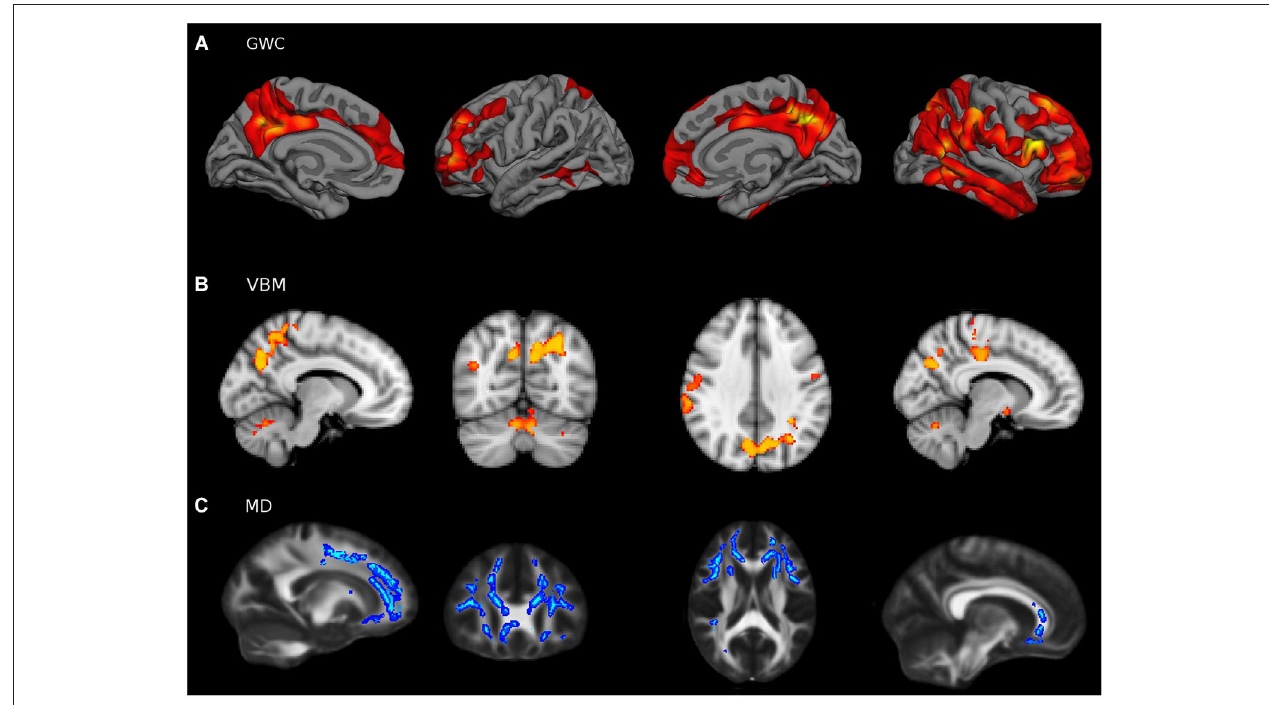
mPFC-PCU connectivity thus reflecting preserved MD integrity. For visual purposes, voxel significance is depicted in clusters that survived multiple comparisons. Gray-white matter contrast image is displayed by lateral and medial views of an inflated brain. Voxel-based morphometry slices are shown at x = − 10,10; y = − 66 and z = 34 and Mean Diffusivity slices are obtained in x = − 18,20; y = 28, z = 18.